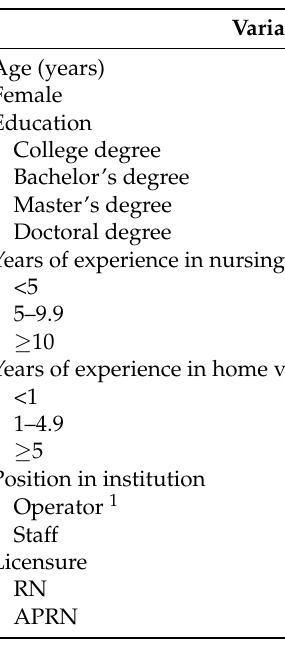
Table 1. Participant characteristics ( N =